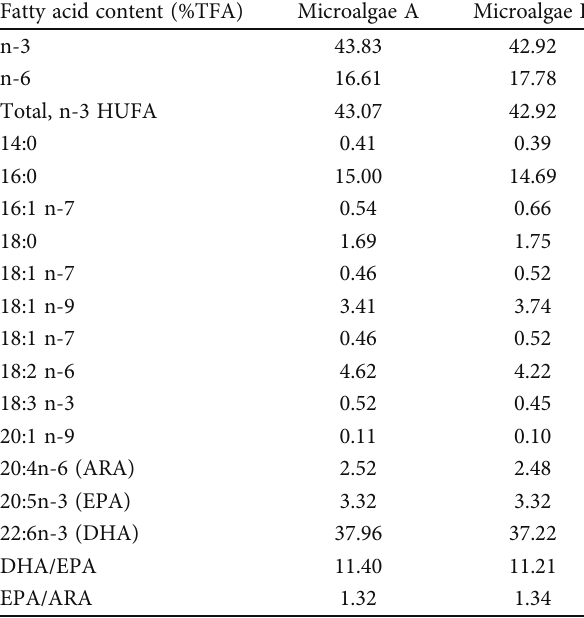
Table 1: Fatty acid composition (%TFA) of two experimental emulsions with selected fatty acid contents (percentage of total fatty acids (%TFA)).